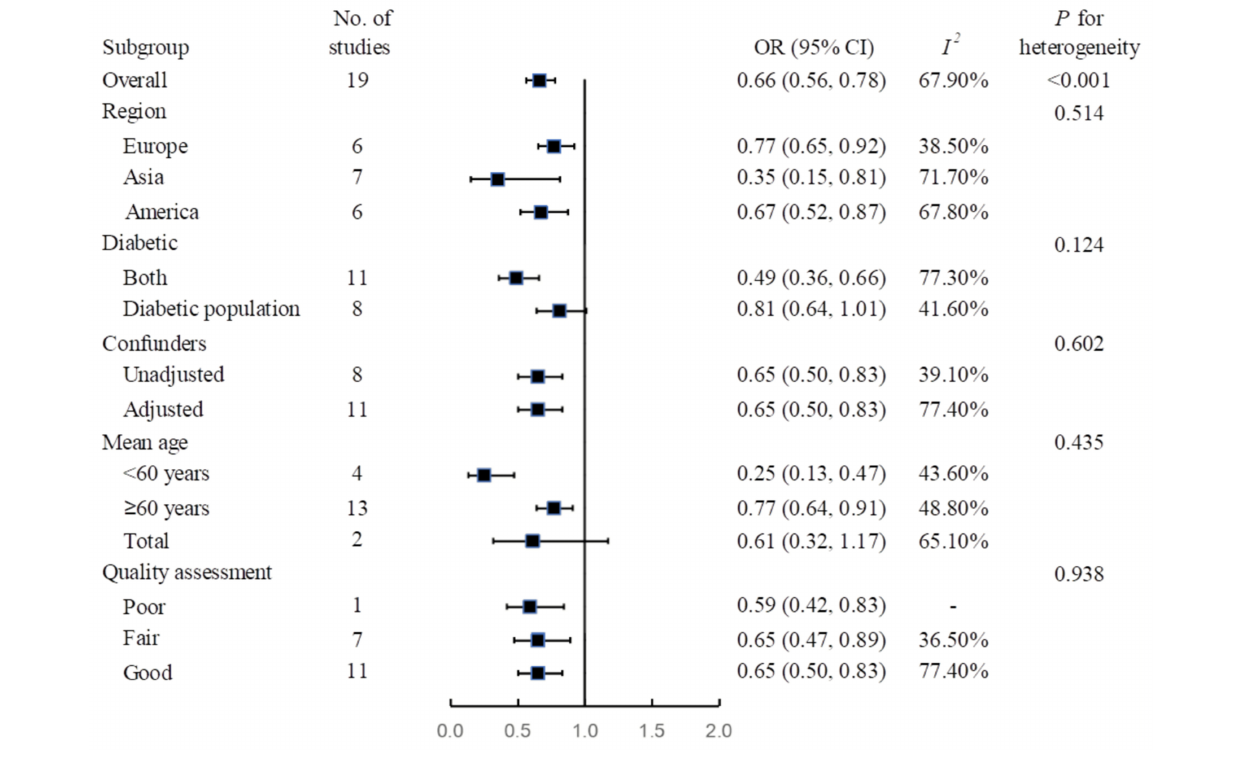
FIGURE 2 | Subgroup analysis of association between metformin use and risk of mortality among COVID-19 patients. CI, confidence interval; OR, odds